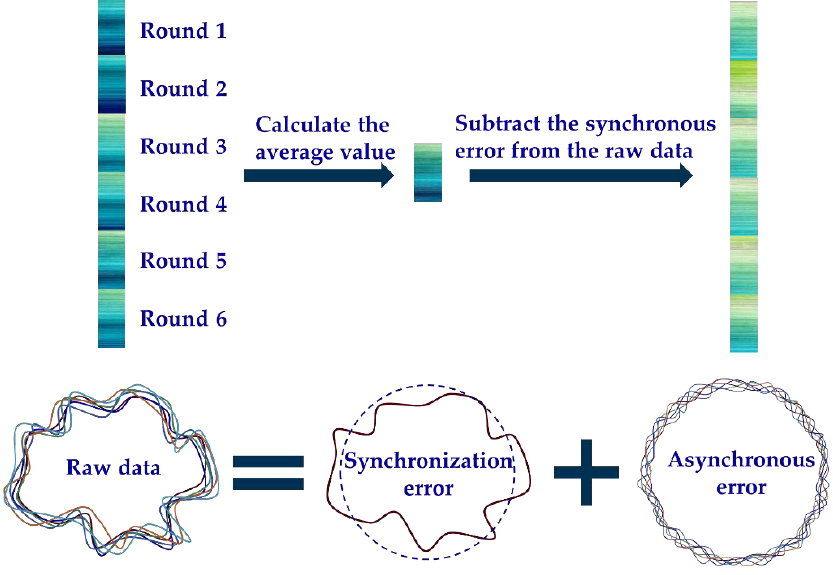
Figure 2. Separation of synchronous and asynchronous errors.